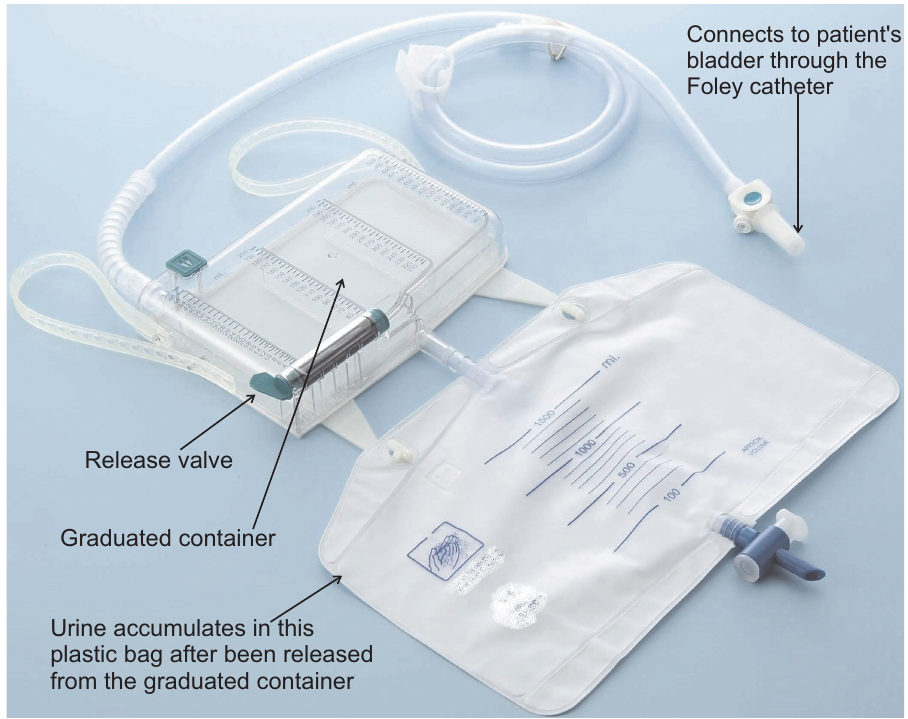
Figure 1. Commercial urine meter used in critical care